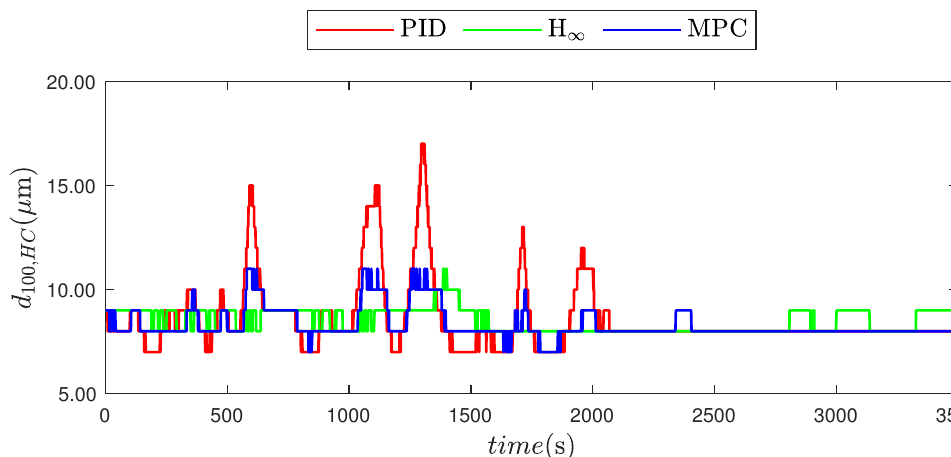
Figure 19. d 100 in separator water-phase outlet (hydrocycone inlet).